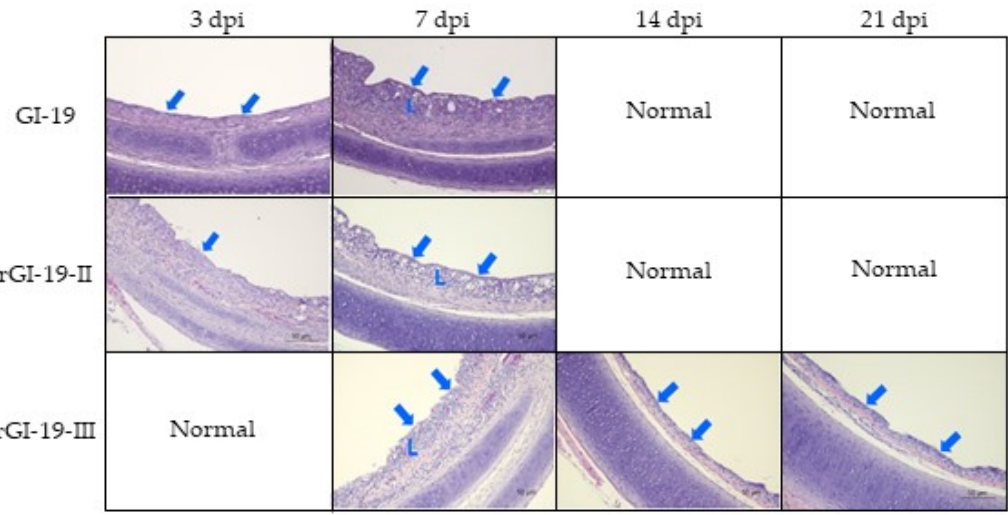
Figure 4. Histopathologic analysis of tracheas from birds infected with GI-19 or rGI-19s. Loss of cilia and cuboidalization of the surface epithelium denoted by arrows, inflammatory cells infiltration in lamina propia by L.